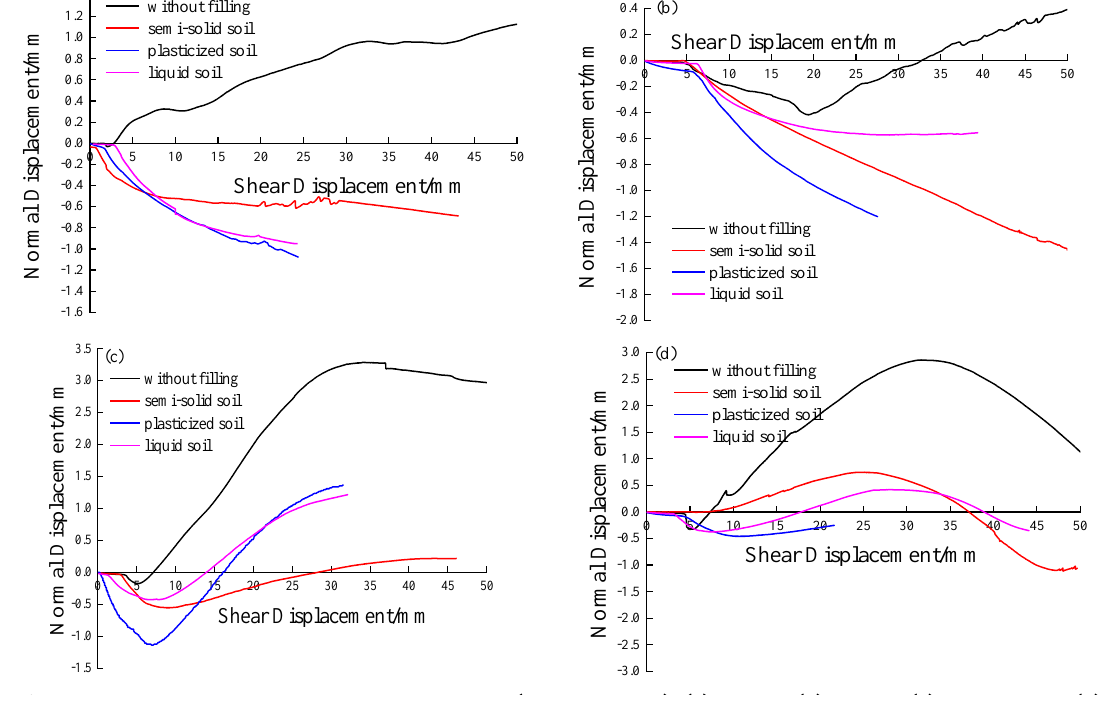
Fig.12. Test curve of ND and SD in different filling (NS is 1.0 MPa): (a) JRC=3; (b) JRC=7; (c) JRC=15; and (d) JRC=19.